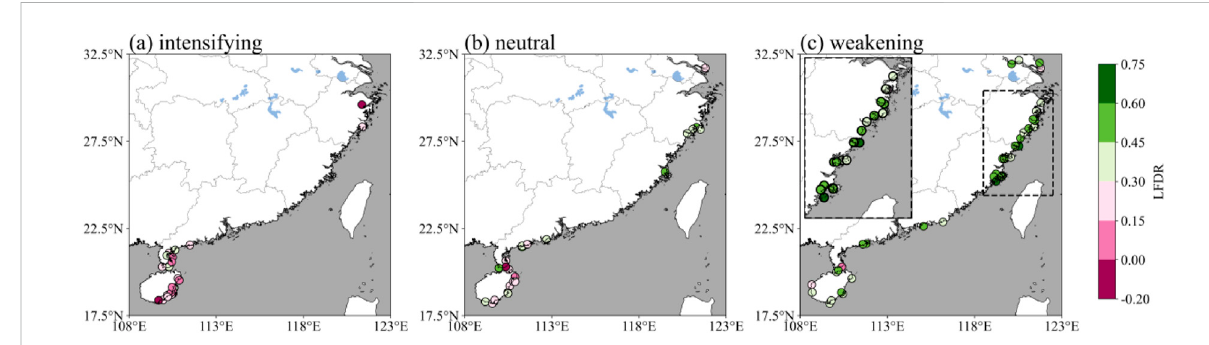
FIGURE 5 Spatialdistributionoflandfallingdissipationrate(LFDR)for (A) intensifying, (B) neutral, (C) weakeningTCs.TheweakeningTCsoverEastChinais magni fi ed in the inset box for clarity in (C) .